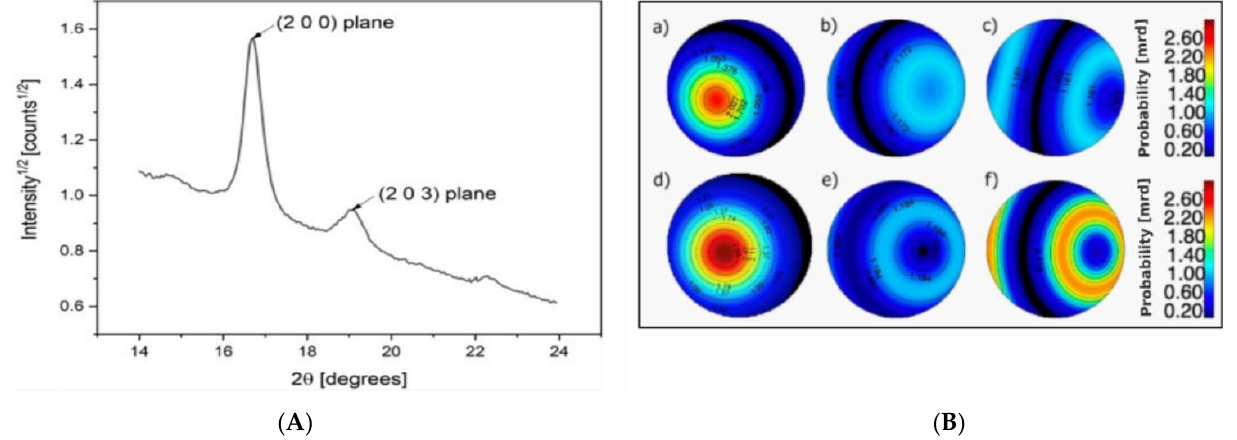
Figure 6. ( A ) Example of a 1D XRD diffraction pattern of a PLA − as sample, ( B ) polar figures showing the preferred orientations of the (200) plane for ( a ) PLA − as, ( b ) PEF − 10% − as, ( c ) PDoF − 10% − as, ( d ) PLA − DR2, ( e ) PEF − 10% − DR2, and ( f ) PDoF − 10% − DR2 fibers. Equal area projection on the fiber axis plane; pole density scale expressed in M.R.D. Table 3. Semi − quantitative results of the XRD data modellization.